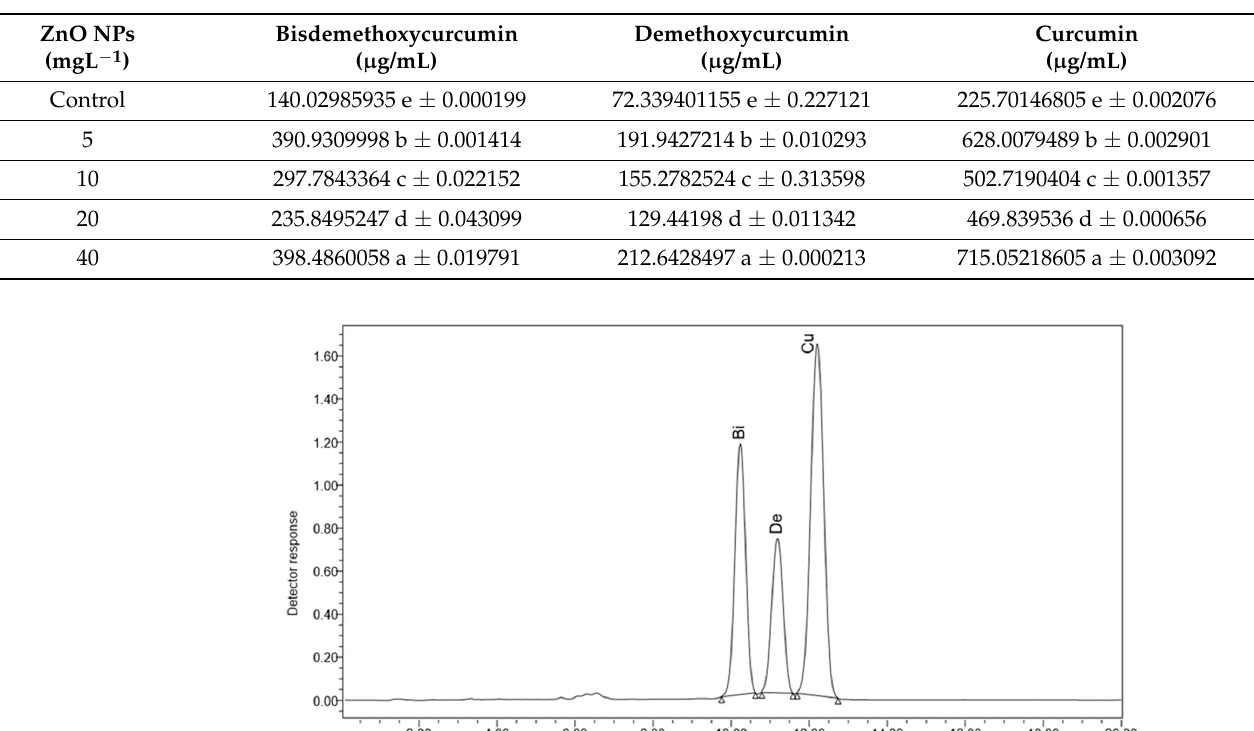
Table 9. Effects of zinc oxide nanoparticles (ZnO NPs) treatments on bisdemethoxycurcumin, demethoxycurcumin, and curcumin ( µ g/mL) accumulation of C. longa . Mean values followed by the same letter within a column are not significantly different at p = 0.05, as measured by Duncan’s test.